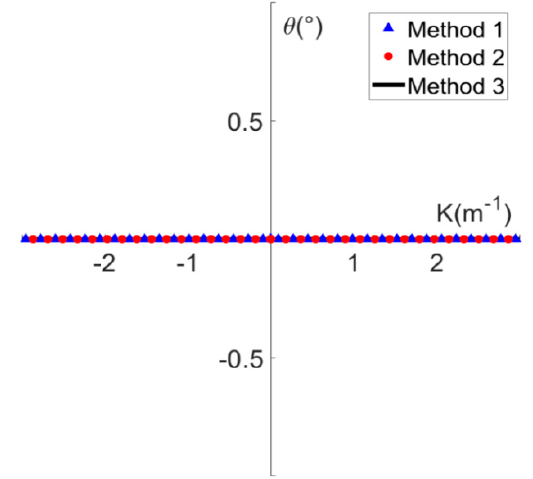
Figure 13. Height of neutral axis in CASE 3.